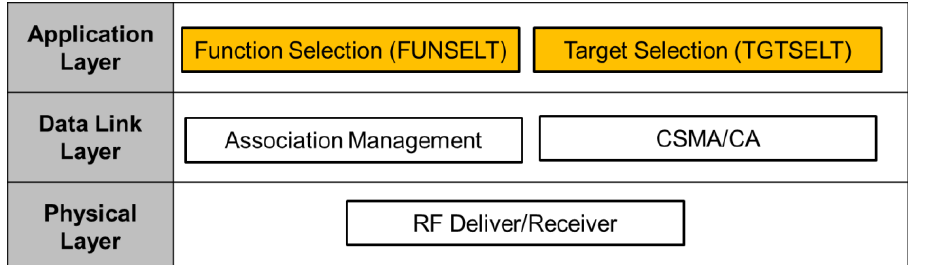
Figure 2. Three-layer wireless control